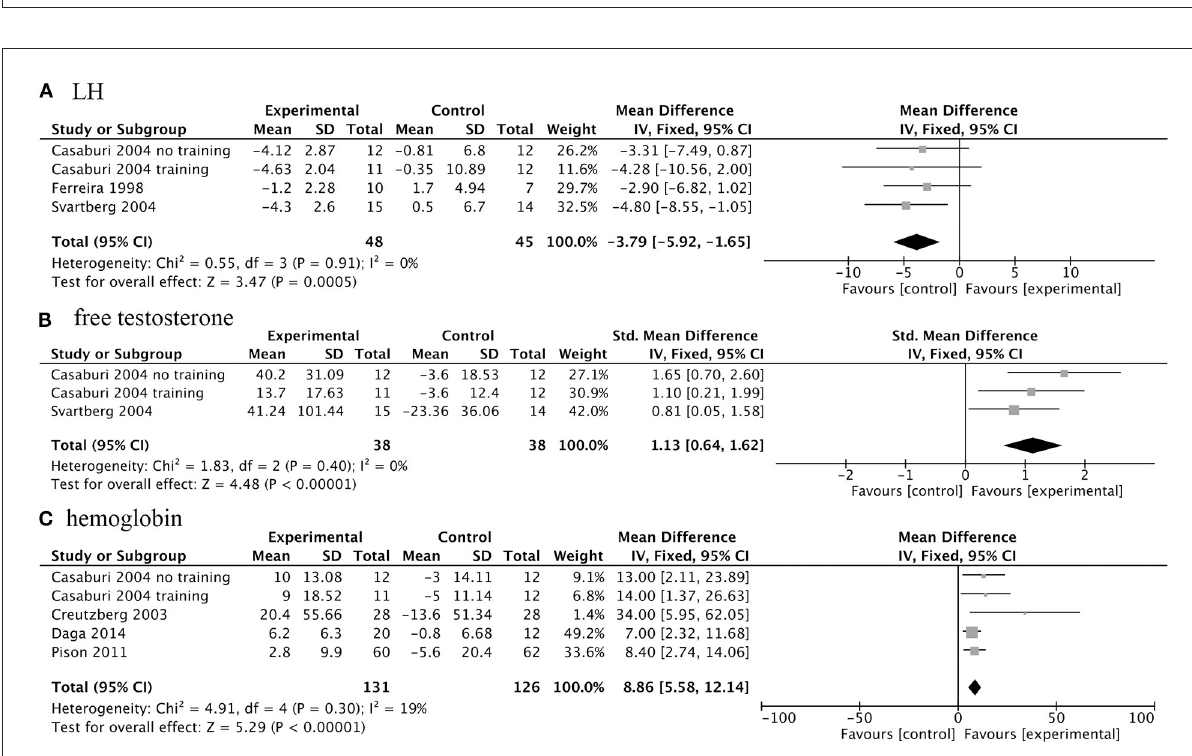
FIGURE6 Forest plots of meta-analysis of biochemical indicators. Fixed-effects meta-analysis of effectiveness of AASs on luteinizing hormone (LH) (A) , free testosterone concentration (B) and hemoglobin (C) of COPD.